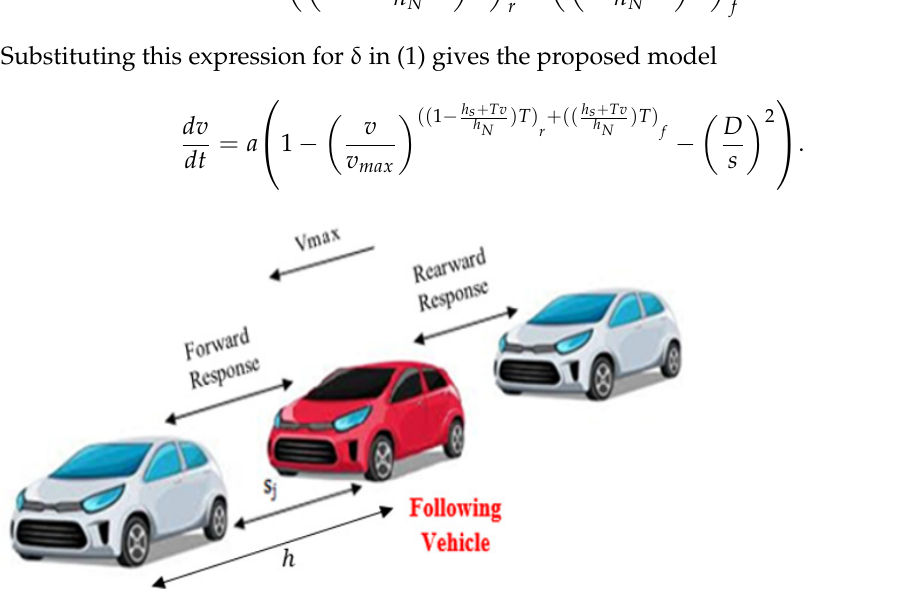
Figure 2. The parameters for the proposed model.